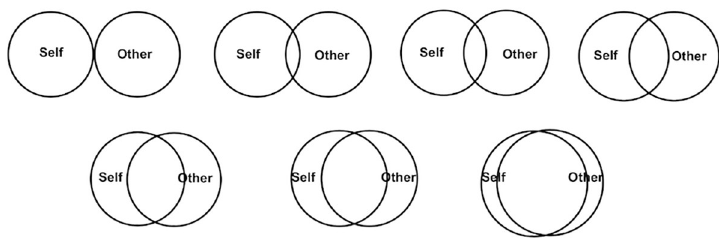
Fig 1. The Inclusion of Other in the Self scale based on Aron et al. (1992). In our study, “Self” referred to “My child” and “Other” referred to “Other students at school”. circles. The two circles show increasing overlap starting from the first to the seventh picture (Fig 1). The extent of the overlap is intuitively understood by the respondents as the closeness of the relationship between the subjects presented in the two circles, for example between the responder and the “Other” identified in the circle; a higher overlap stands for a closer relation- ship. The respondent is asked to indicate which of the seven pictures best represents the rela- tionship with the “Other”. In our study, the relationship between the SEN student and “Other” where this stands for “Other students at school” is reported by the parents of the SEN students.